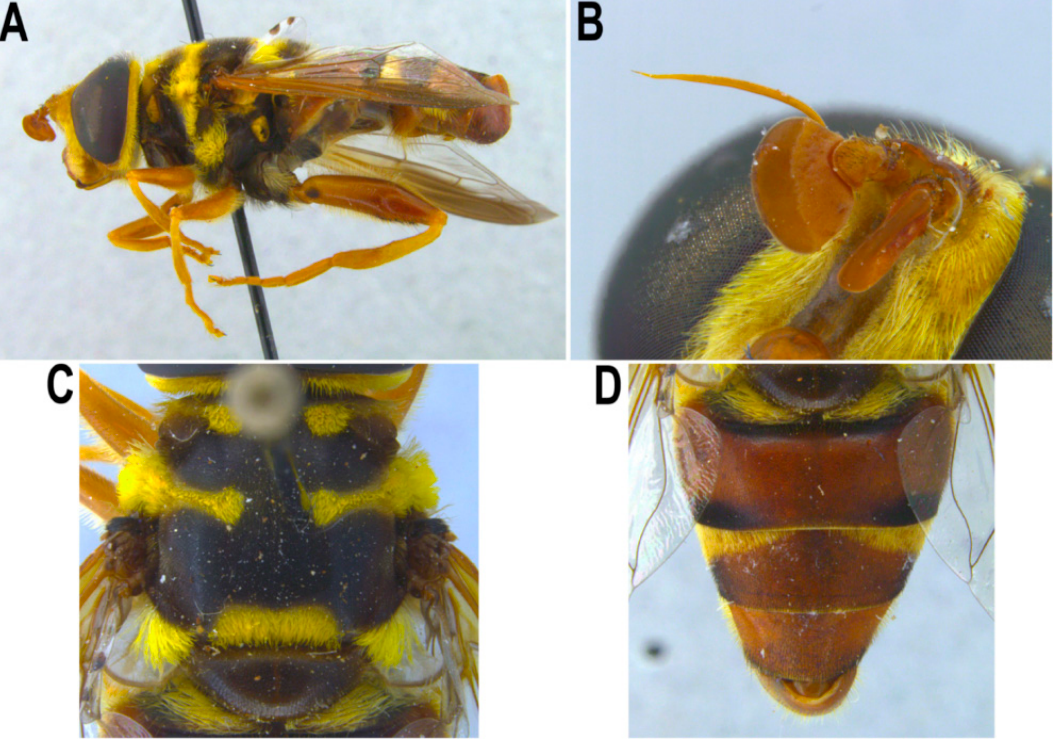
Figure 14. Meromacrus ruficrus , adult male. ( A ): entire body, lateral view. ( B ): right antenna, lateral view of inner side. ( C ): thorax, dorsal view. ( D ): abdomen, dorsal view.